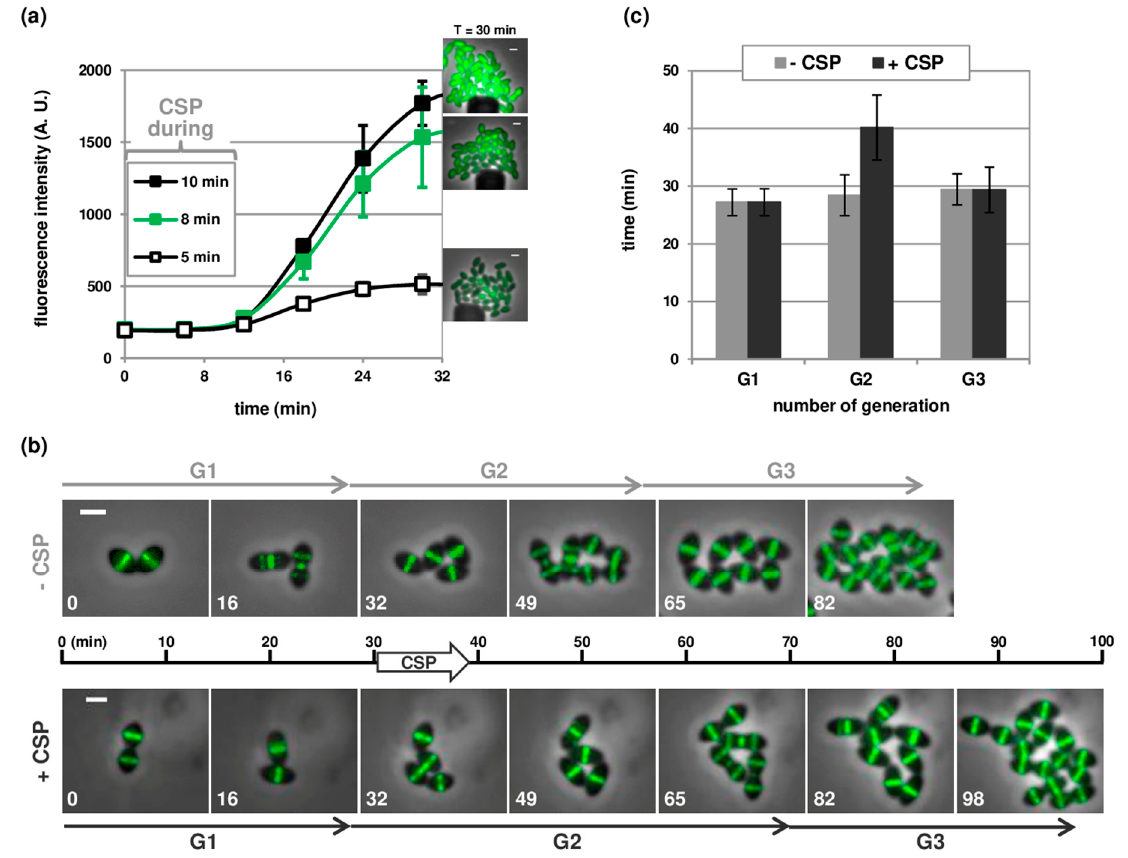
Figure 2. Competence-stimulating peptide (CSP)-dependent competence induction in microfluidic chambers. ( a ) Kinetics of expression of P E - gfp (strain R4254) in response to CSP addition at a concentration of 500 ng / µ L and a flow rate of 23 µ L / h (6 psi) for 5 min (open square), 8 min (green square) and 10 min (black square). Average fluorescence intensities per µ m 2 are based on time-lapse microscopy images and shown in arbitrary units (A.U.). More than 200 cells were analyzed per time point and per experiment. Time zero corresponds to the onset of CSP perfusion. Averages of three replicates are shown. Error bars show standard deviations. Some of the error bars are too small to be shown. Selected fluorescence microscopy images acquired at 30 min are shown on the right side. Overlays between phase contrast (gray) and Green Fluorescent Protein (GFP) (green) are shown. Scale bar, 1 µ m; ( b ) Still images from fluorescence time-lapse microscopy of R3702 cells producing a functional FtsZ-GFP fusion. Cells were grown in two parallel microfluidic chambers and induced